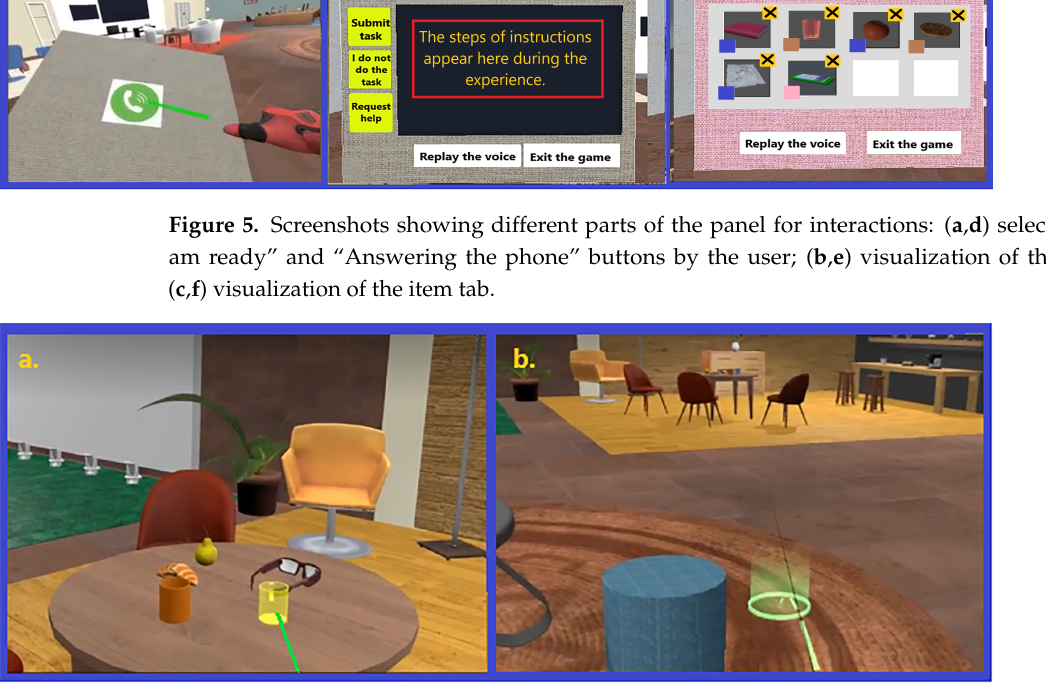
Figure 6. Screenshots showing the participant when: ( a ) removing interactive objects; ( b ) using the teleportation to move in the